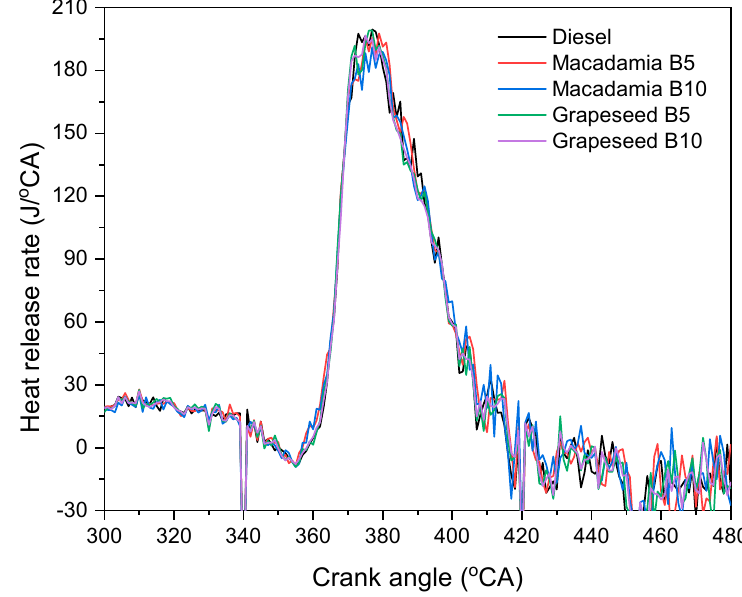
Figure 11. Variation of heat release rate with the crank angle at full engine load condition.